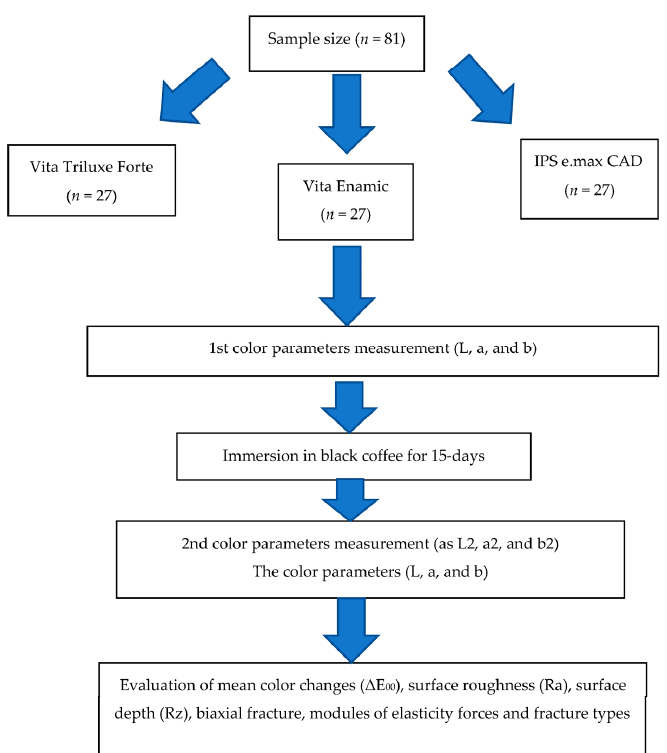
Figure 2. Representation of the groups and subgroups’ distribution for the various tests